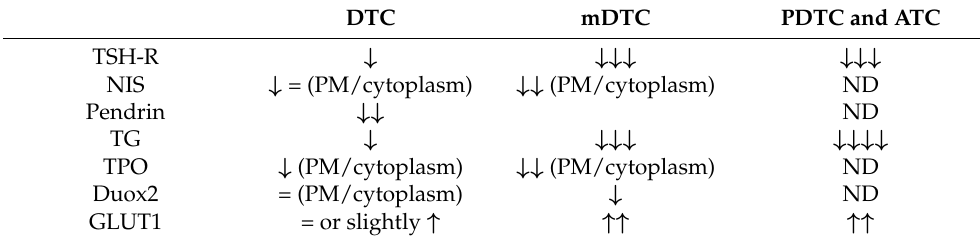
Table 3. Expression level modification of proteins involved in iodine transport and their organization in thyroid cancer compared to normal tissue. ND: not detected; PM: plasma membrane; DTC: differentiated thyroid cancer; mDTC: metastasis of DTC; PDTC: poorly differentiated thyroid cancer; ATC: anaplastic thyroid